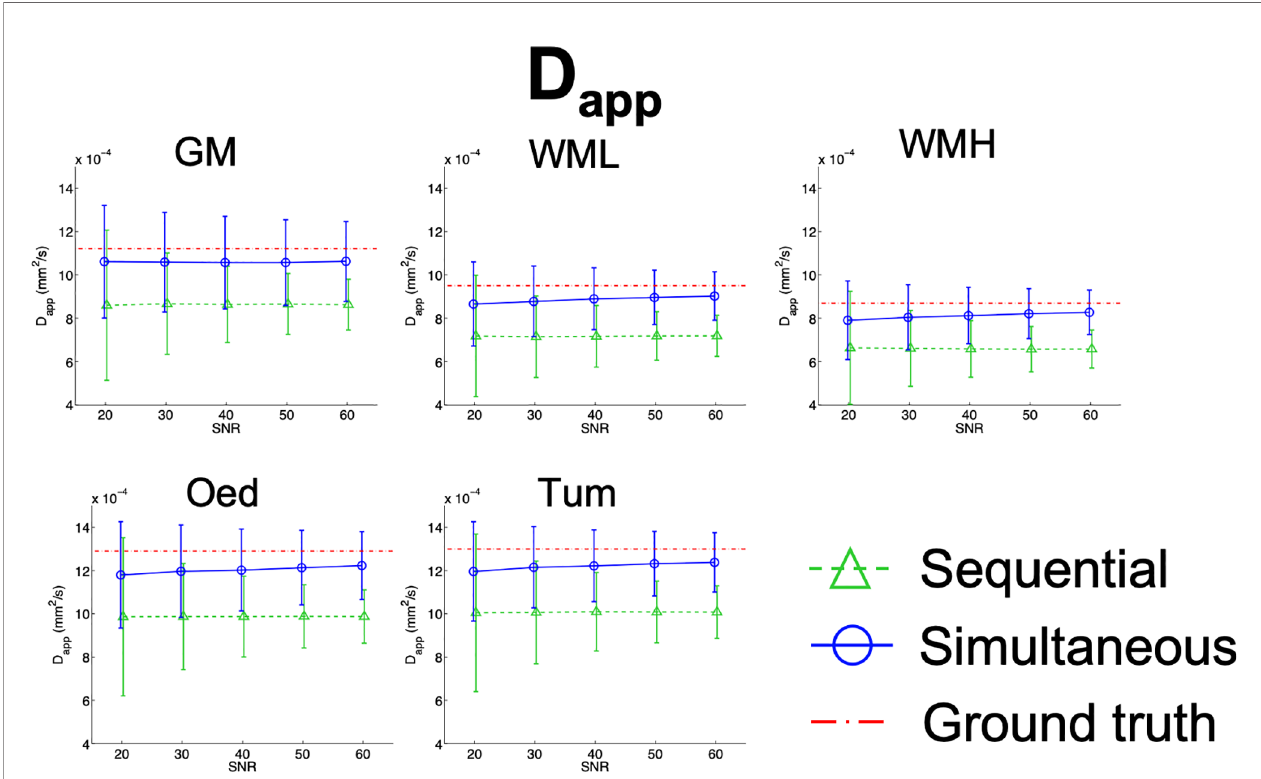
FIGURE 9 | Simulation results plots of D app in all tissues at all SNR levels. The geometric fi gures represent the mean and the vertical bars the standard deviation at each SNR